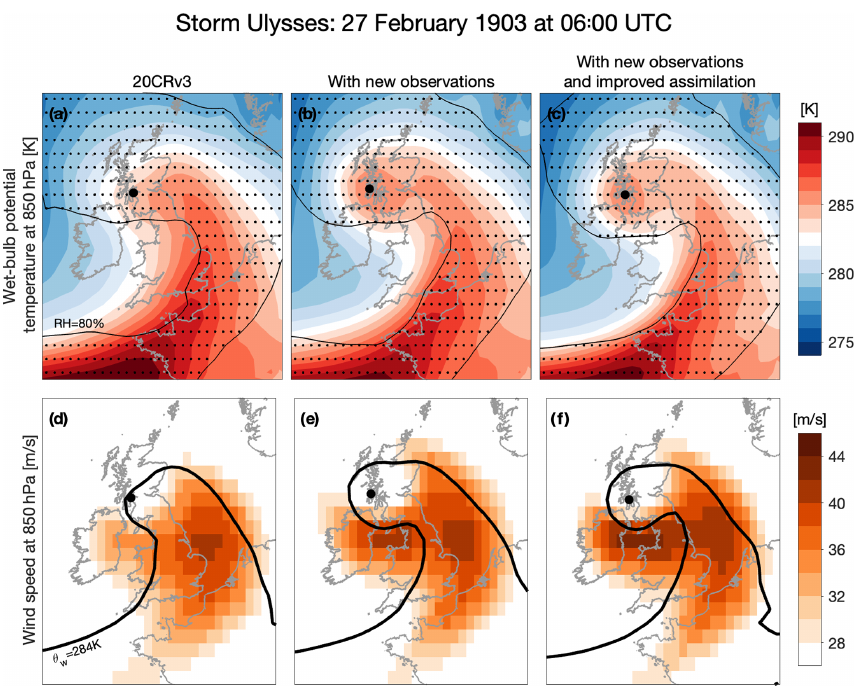
Figure 5. Ensemble mean of wet-bulb potential temperature at 850hPa (top row, a–c) and wind speed at 850hPa (bottom row, d–f) in the original 20CRv3 and two experiments with the reanalysis system (columns) at 06:00UTC on 27 February 1903. The filled black circle represents the position of the mean sea level pressure minimum. The top panels also include stippling and a contour representing the location of the cloud head using relative humidity (RH) with respect to ice of above 80% at 700hPa. The 284K isotherm is indicated with the thick black contour in the bottom